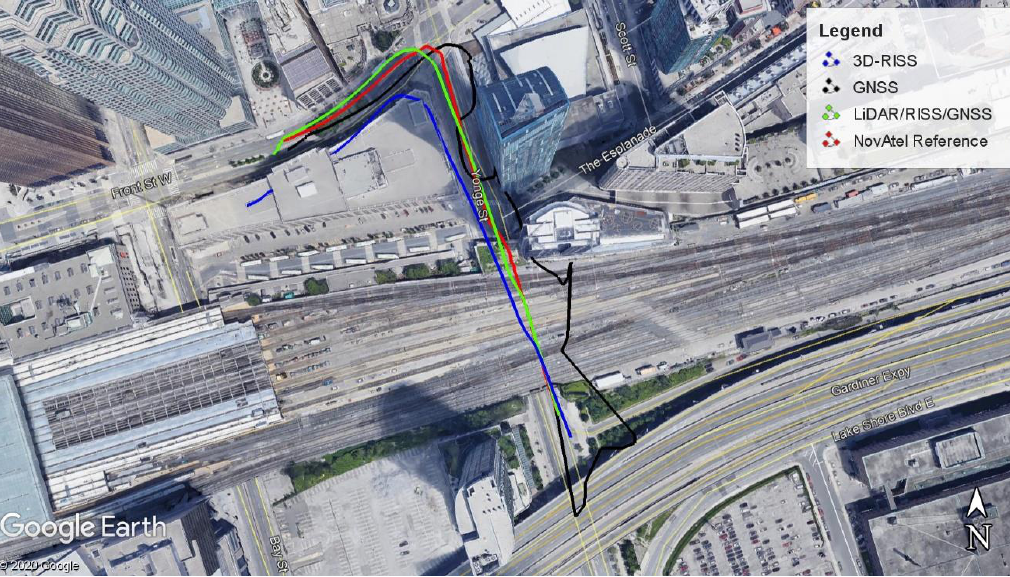
Figure 27. Navigation solution for 3D-RISS, GNSS, LiDAR/RISS/GNSS, and NovAtel